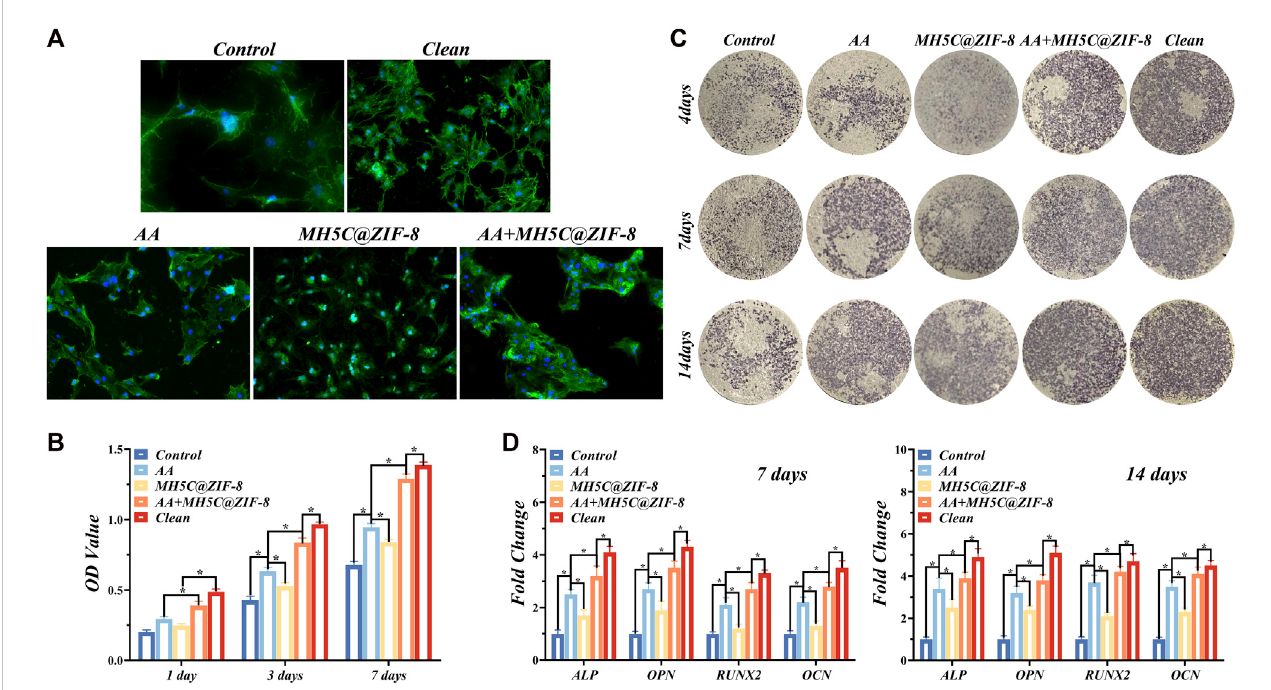
FIGURE 5 Re-osseointegration on contaminated titanium plates treated with erythritol air-polishing coupled with MH5C@ZIF-8 NPs. (A) Fluorescent images of BMSCs cultured on contaminated titanium plates after different treatments. (B) Cell proliferation assay of BMSCs cultured on contaminated titanium plates after different treatments. (C) ALP staining of BMSCs cultured on contaminated titanium plates after different treatments. (D) Osteogenic-related gene expression after culturing for 7 and 14